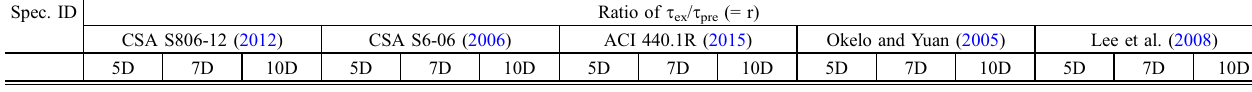
Table 7 Ratio of experimental and code predicted bond strengths for LM and HM